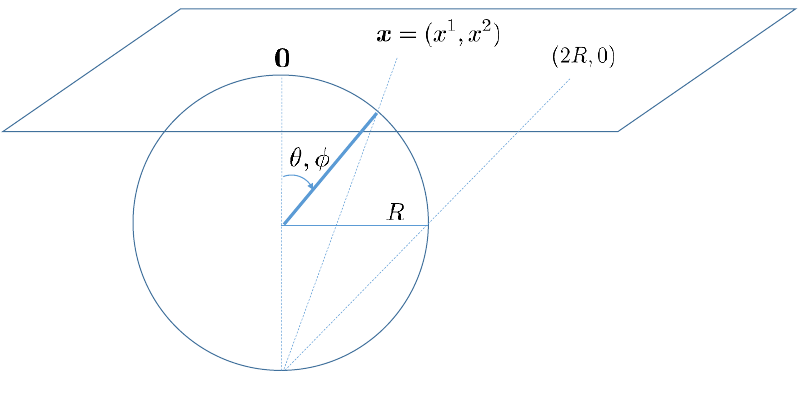
Figure 5 . The geometry of the stereographic projection. The ‘transverse’ plane is tangent to the sphere at the ‘North Pole’, while the projection point is the ‘South Pole’. The Equator on the sphere is projected on a circle in the plane with radius equal to D = 2 R